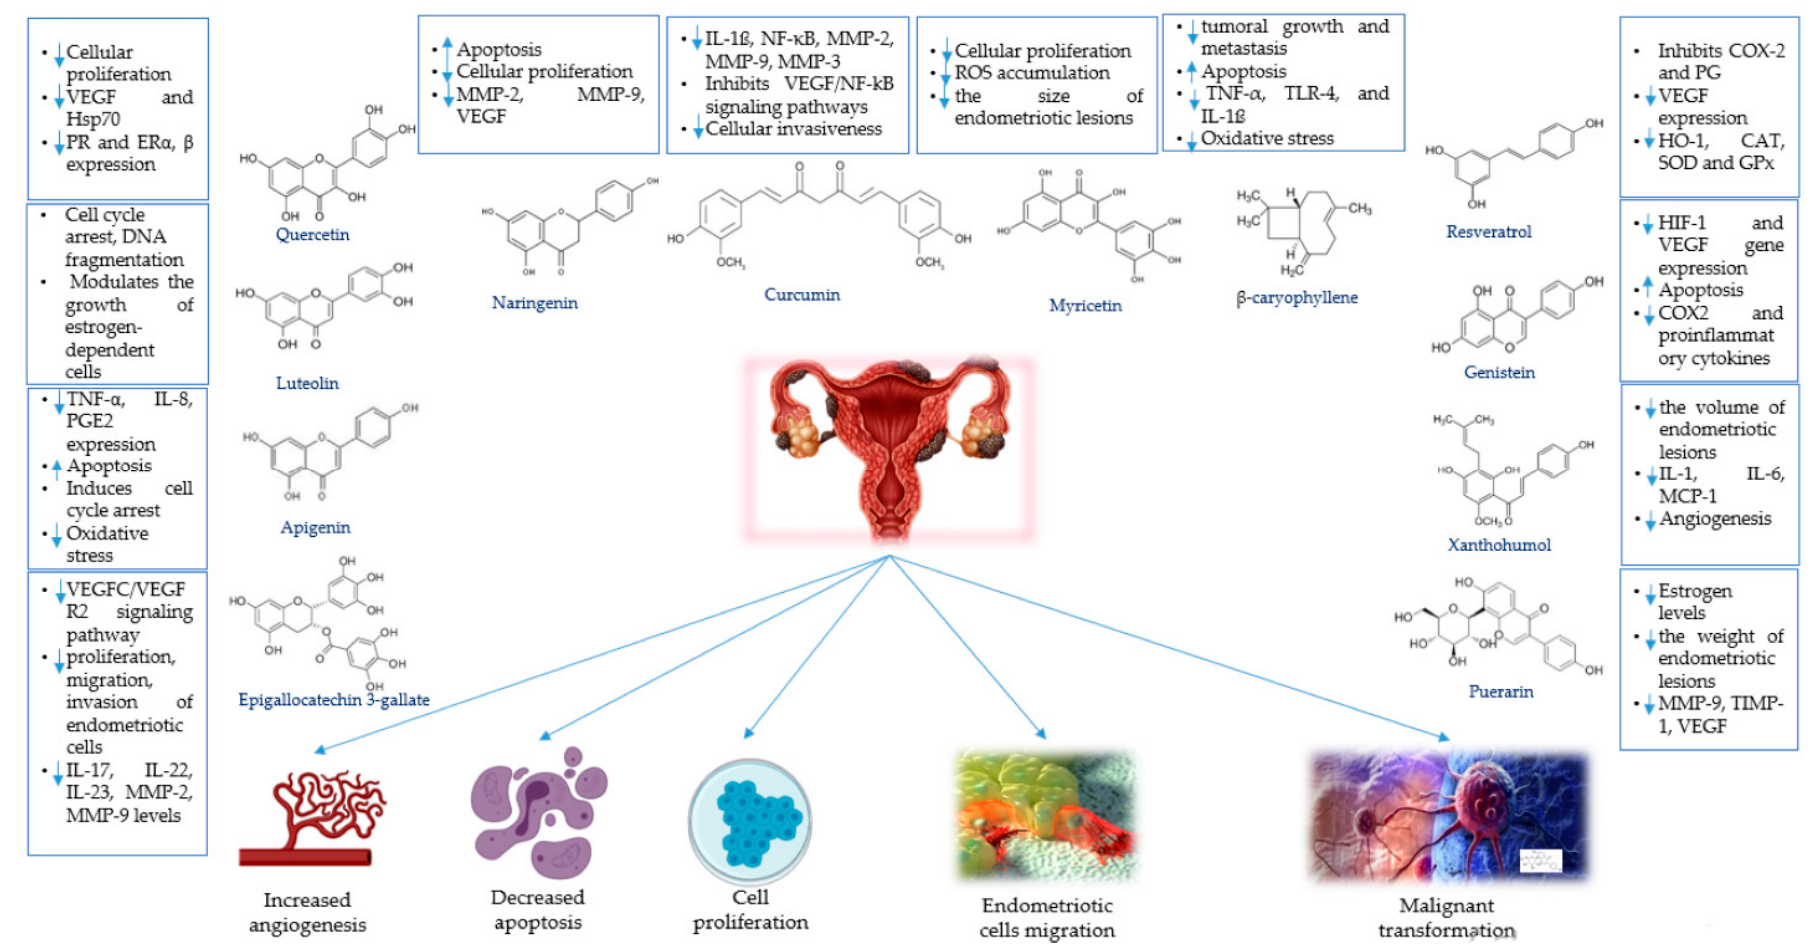
Figure 1. Endometriosis pathogenic mechanisms and the main mechanisms of action of various phytochemicals.